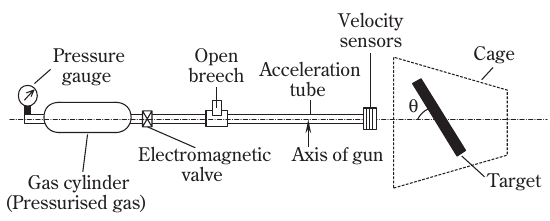
Fig. 1 Typical arrangement for single-particle